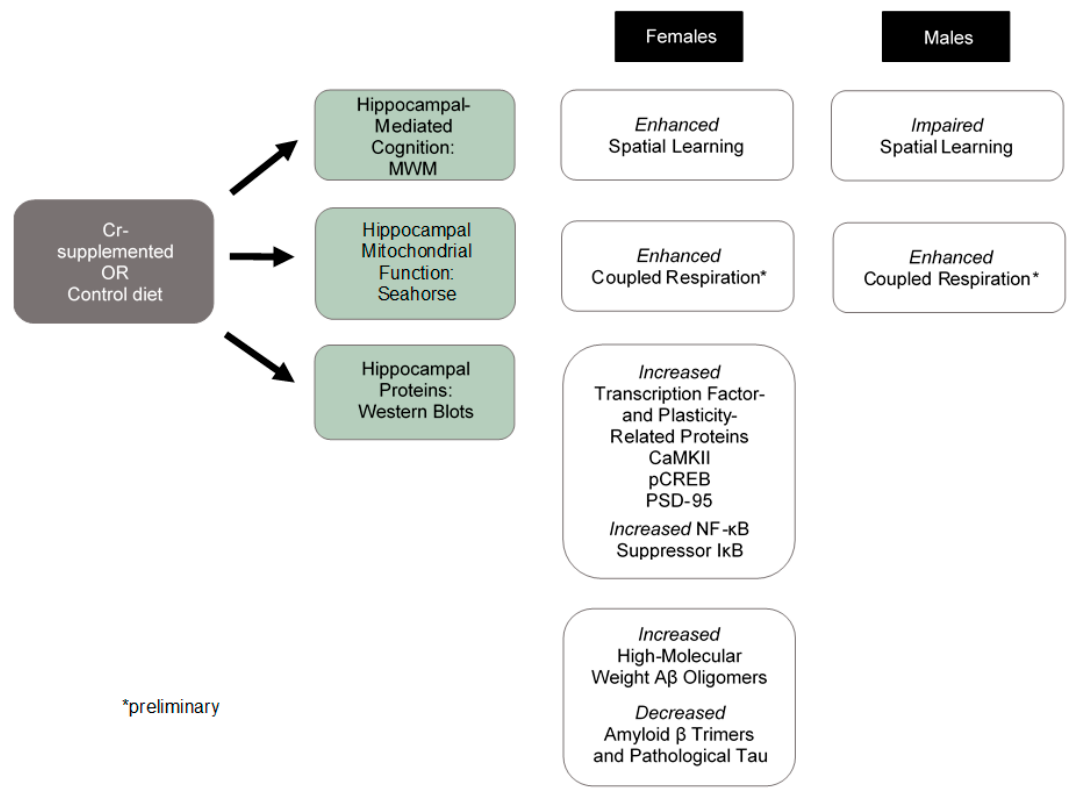
Figure 14. Summary of findings in 3xTg mice. Cr supplementation resulted in sex-specific effects on spatial cognition, as measured by the Morris water maze (MWM). Preliminary findings in isolated mitochondria from both sexes demonstrated consistent effects of Cr supplementation on coupled respiration. Western blot experiments were conducted in female 3xTg mice only due to the small sample size of Cr-fed males.